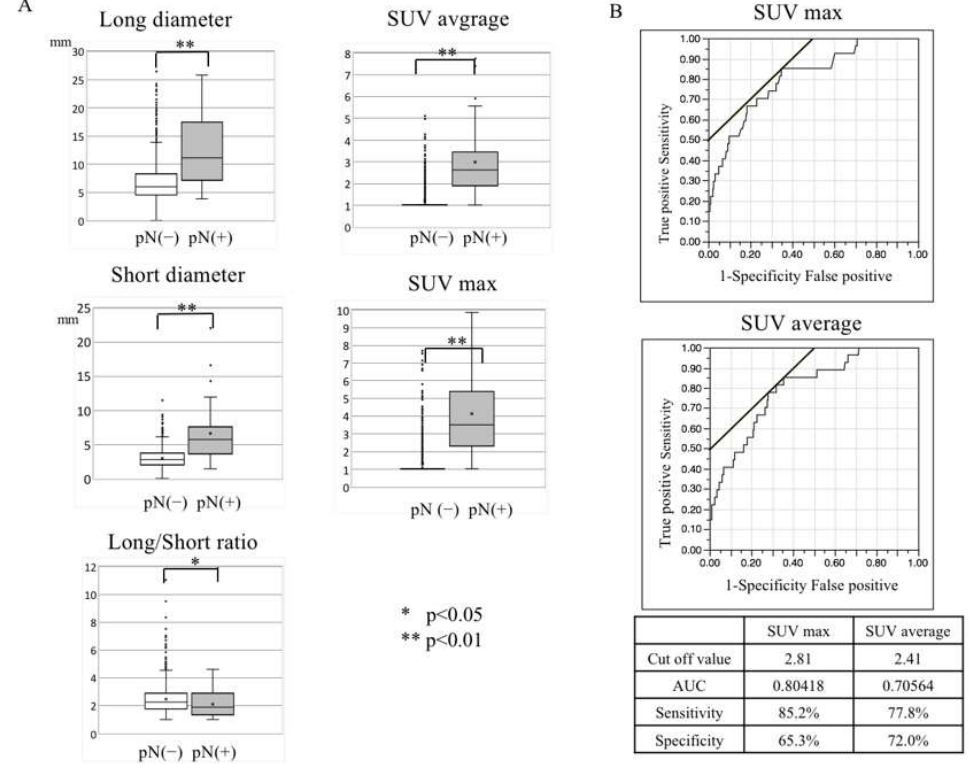
Figure 1. ( A ): Distribution of imaging factors in metastatic lymph nodes and non-metastatic lymph nodes. The central line is the median. The central mark “ × ” is average. The box is the 25–75% confidence interval. The vertical line is the 95% confidence interval. The dots are outliers. ( B ): ROC curve and cut-off value of SUV max and SUV average .